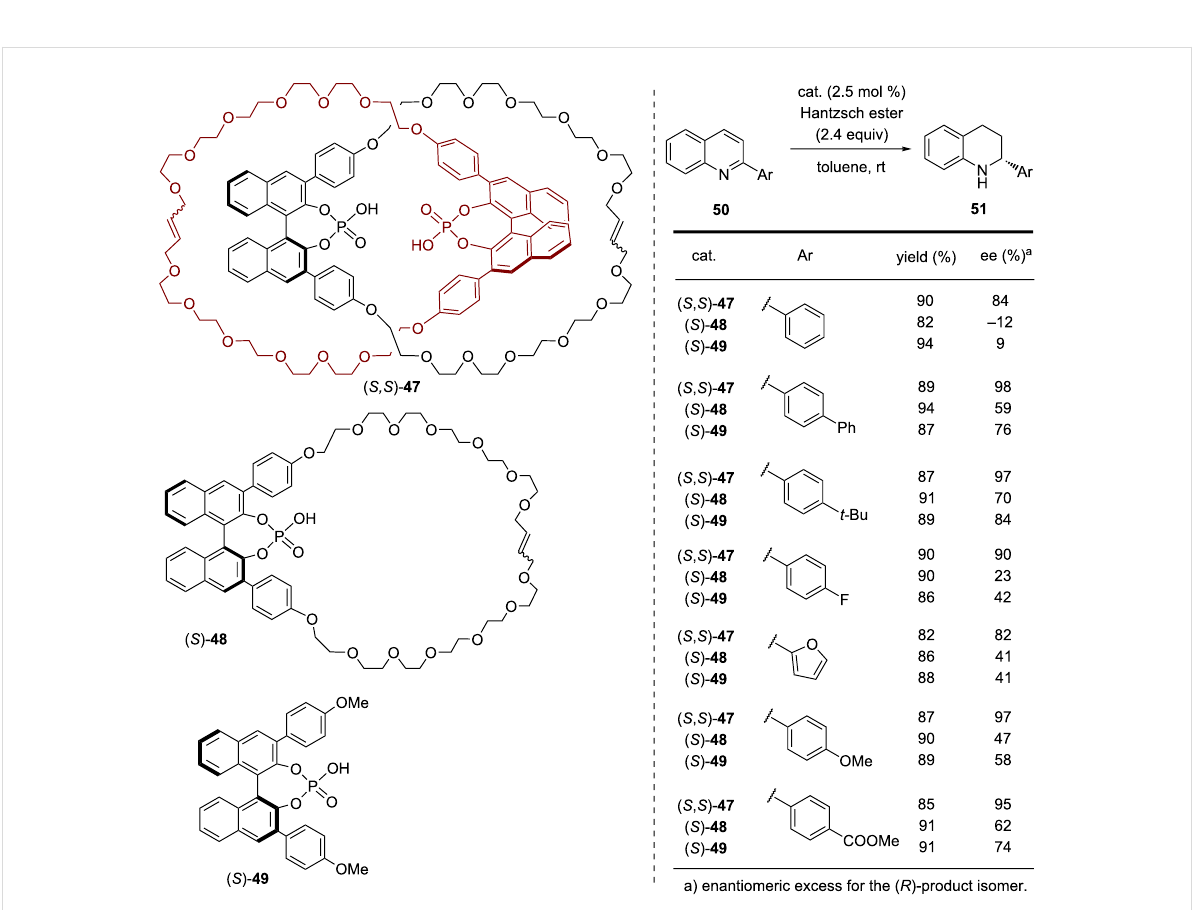
Figure 12: Synthesis of Niemeyer´s axially chiral [2]catenane ( S,S )- 47 .